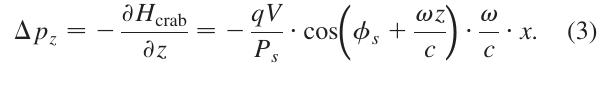
FIG. 2. (Color) Schematic for two crabbed beams at IP5, local scheme (with (cid:2) denoting the full crossing angle) (left); sche- matic of only one crabbed beam at LHC IP5 with a single global crab cavity, for beam 1 only